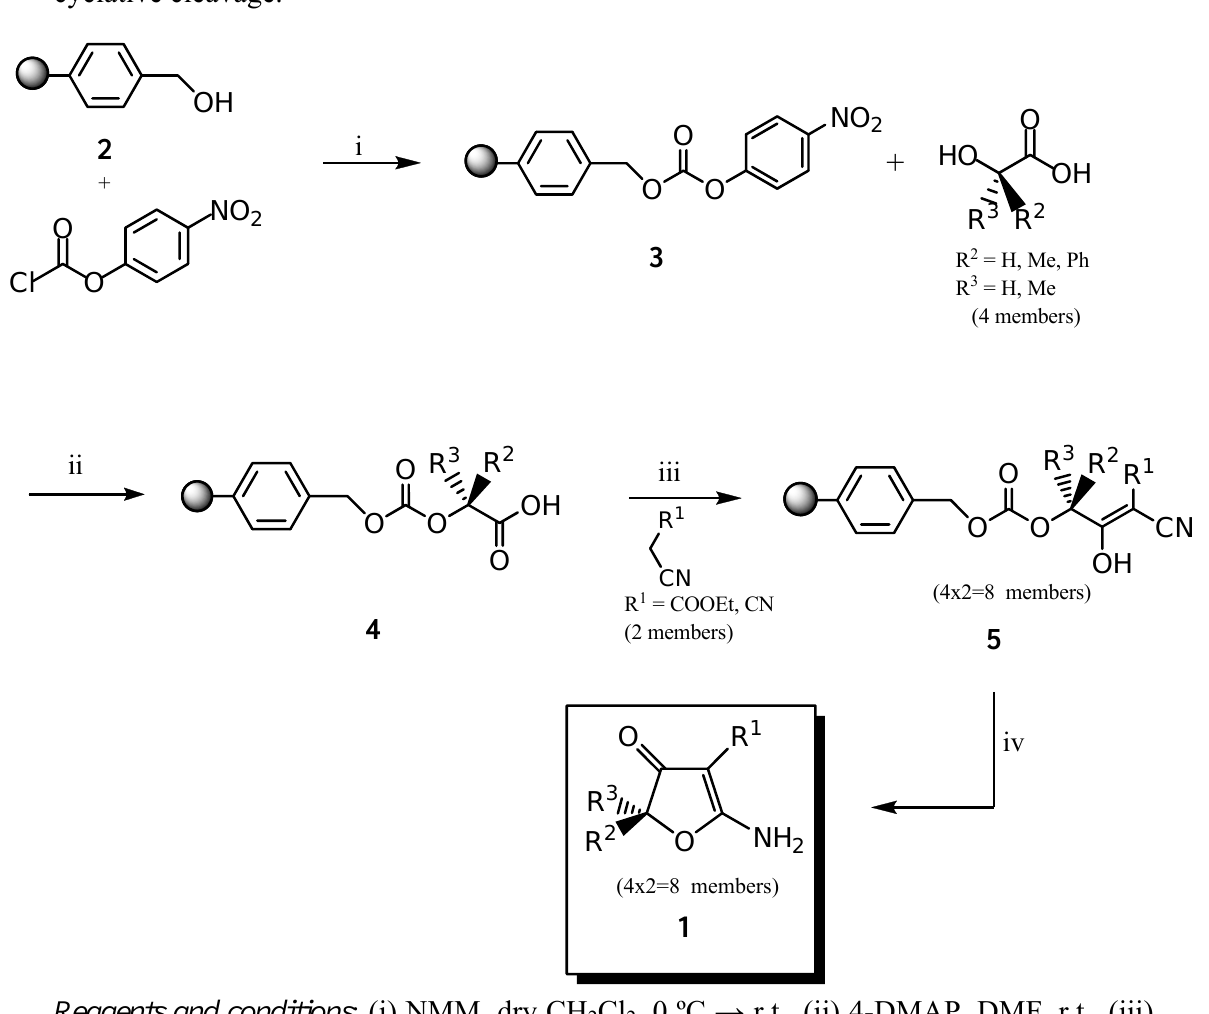
Scheme 1. Synthetic protocol methodology for 3, 5-disubstituted-2-aminofuranones via cyclative